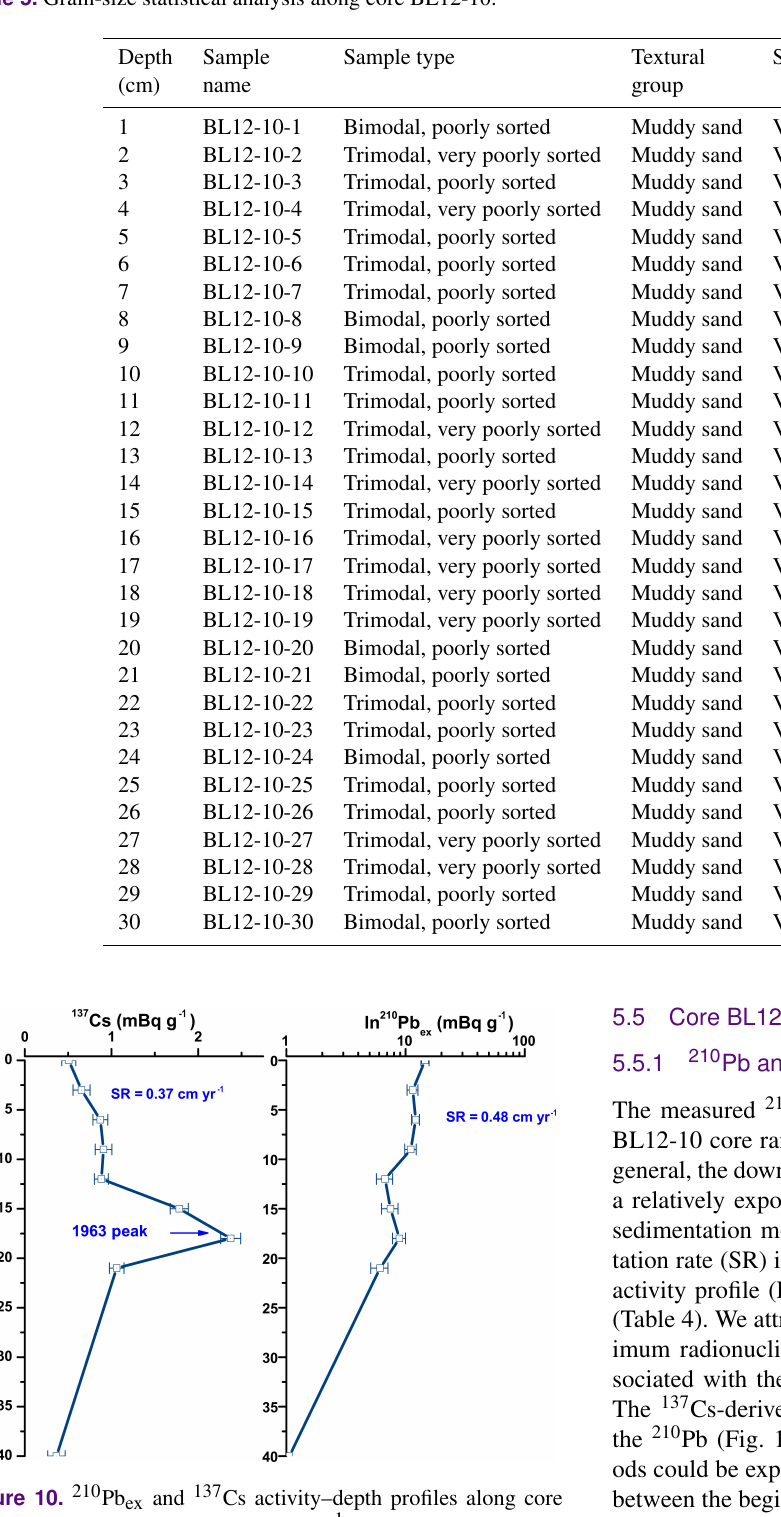
Table 5. Grain-size statistical analysis along core BL12-10.